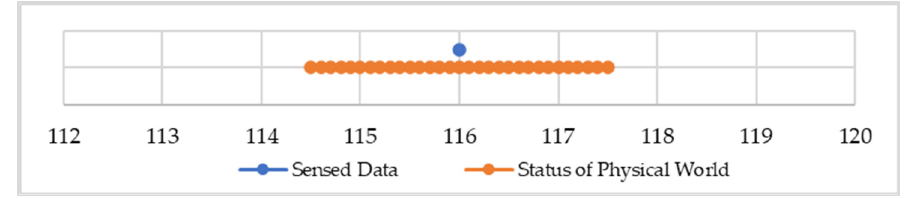
Figure 5. The bounded-error range of the raw data of voltage 116.